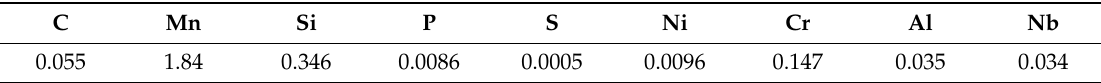
Table 5. Chemical composition, weight